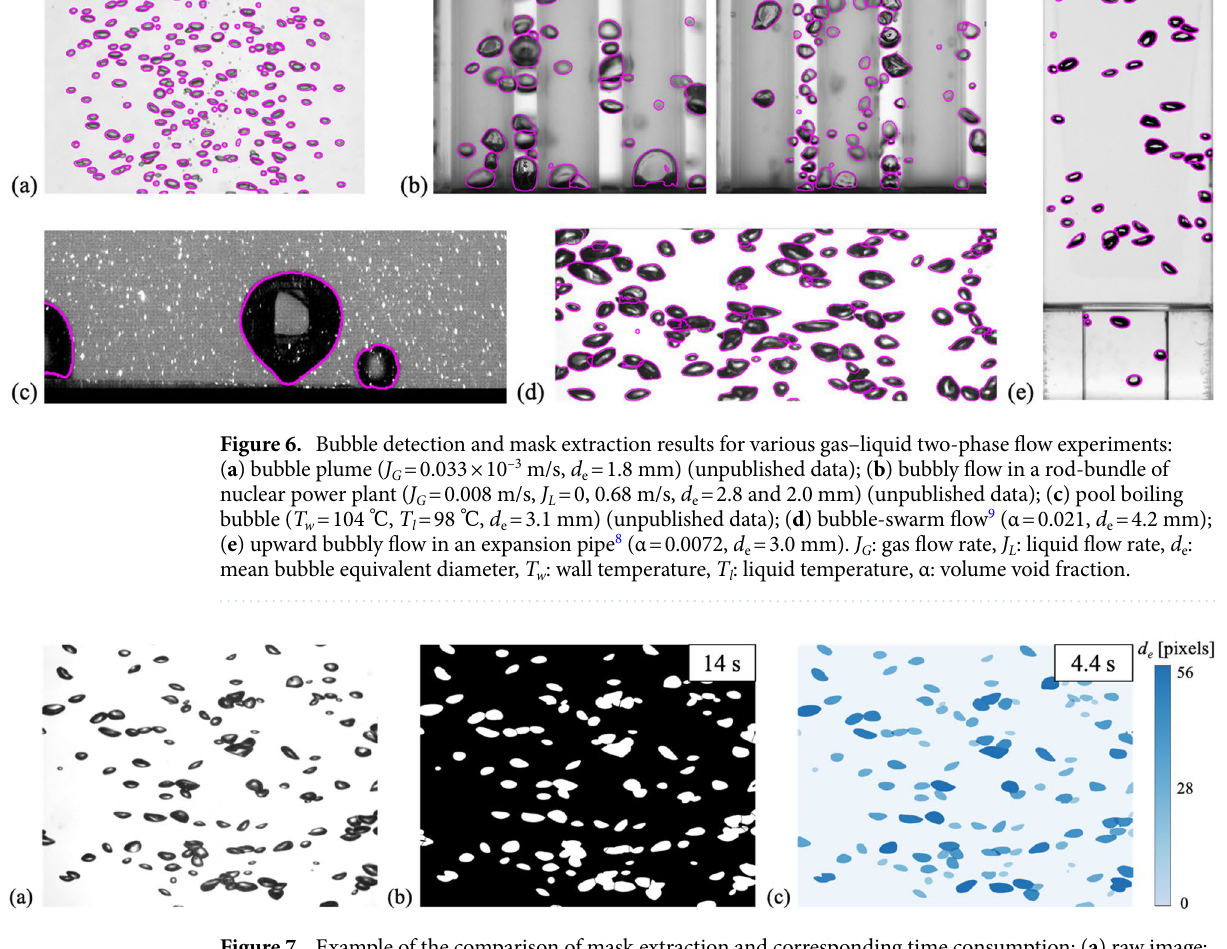
Figure 7. Example of the comparison of mask extraction and corresponding time consumption: ( a ) raw image; ( b ) result of conventional image processing; ( c ) result of present model. The image was obtained from the bubble-swarm flow 9 with void fraction of 0.9% and has a resolution of 1248 × 976